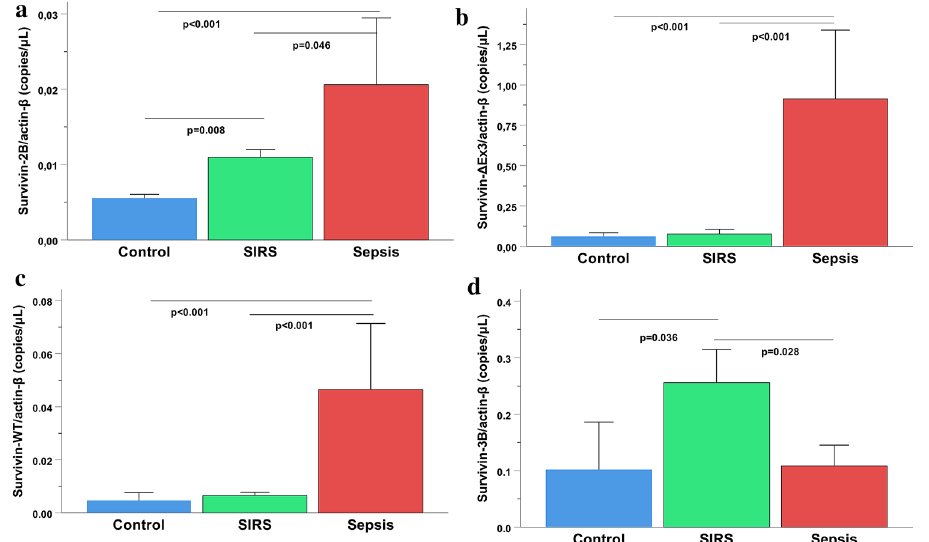
Figure 2. Gene expression levels of survivin isoforms: ( a ) Survivin-2B; ( b ) Survivin-ΔΕx3; ( c ) Survivin-WT; and ( d ) Survivin-3B in the three study groups. Bars represent Medians, error bars 95% Confidence Intervals. Connectors indicate significant difference between septic and non-septic critically ill or healthy individuals.